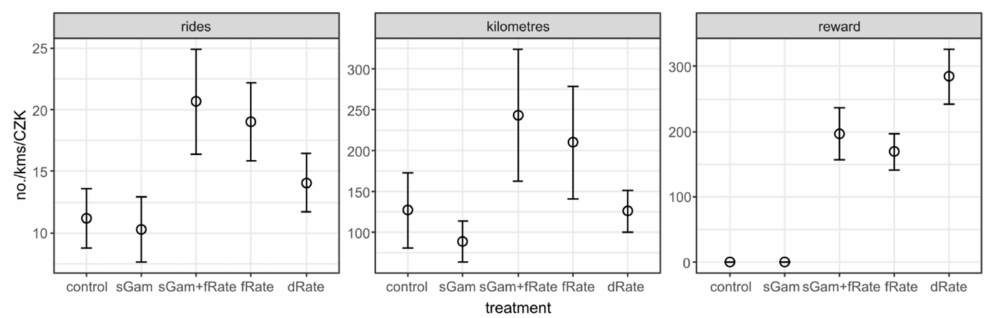
Figure 3. Summary statistics on the number of rides, total length of rides in kilometres, and total financial rewards in CZK per participant. Note: sGam is T1 (smart gamification), sGam + flRate is T2 (smart gamification with a flat rate financial reward), fRate is T3 (flat rate financial reward), and dRate is T4 (decreasing block rate financial